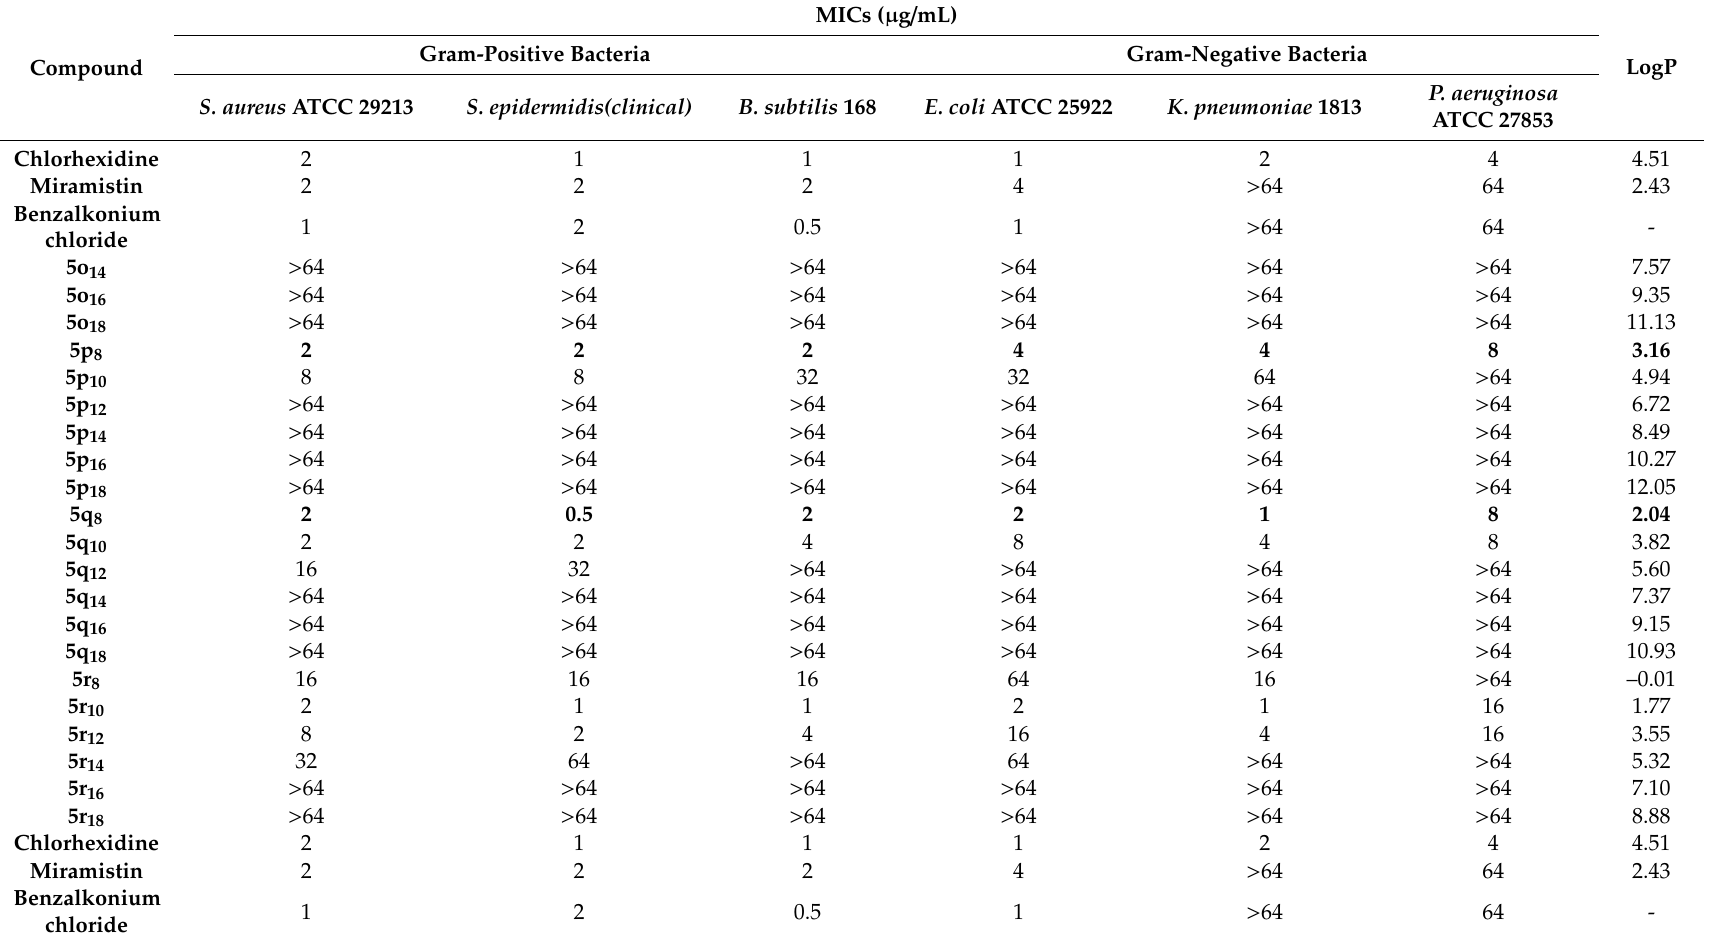
a MICs for the most active compounds are highlighted in